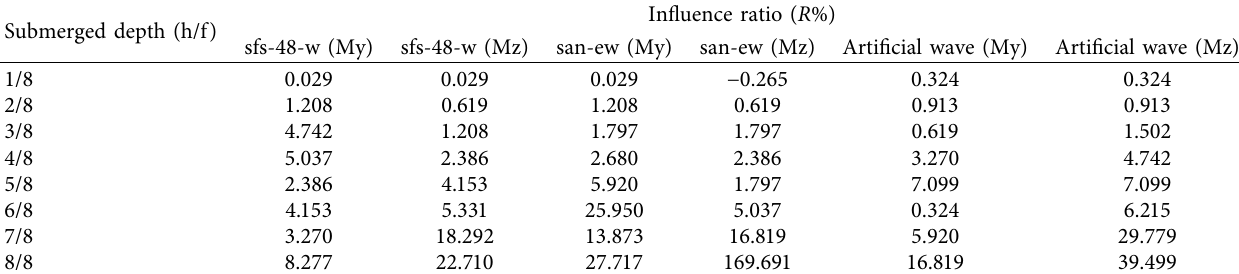
Table 9: Te relation of R and submerged depth at 7L/16 of the arch.